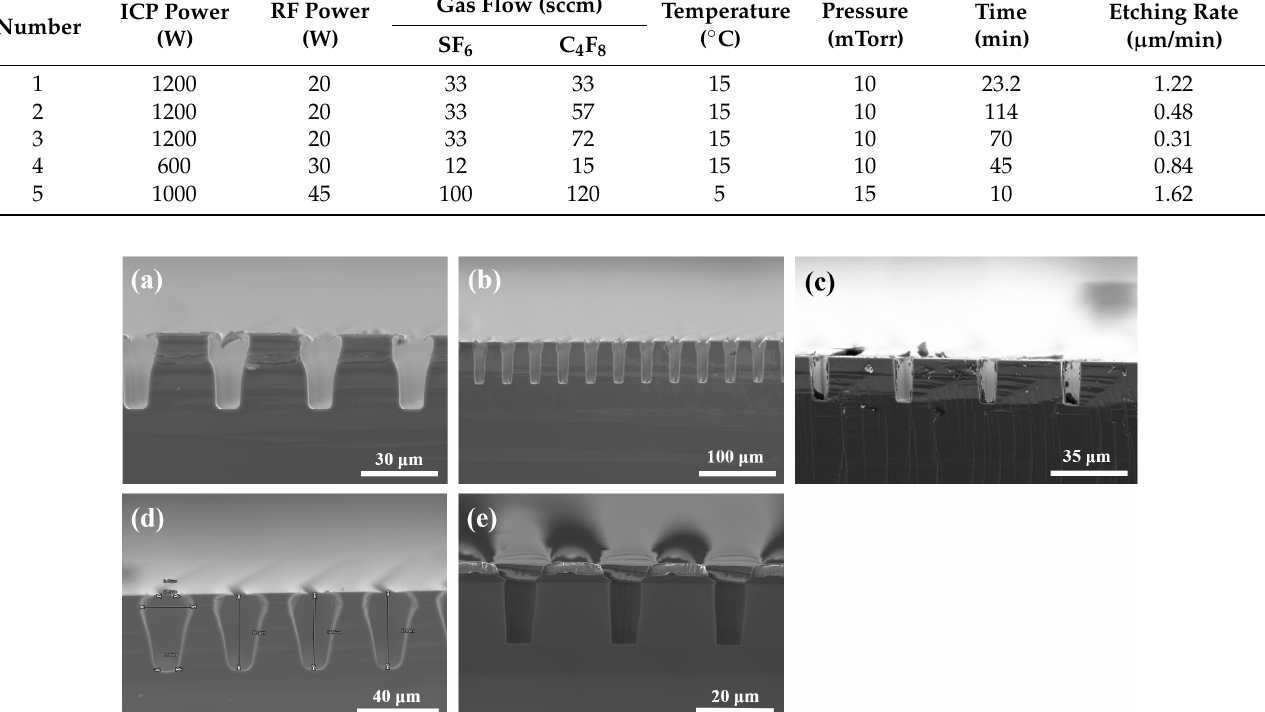
Figure 5. Different profiles of pseudo-Bosch experiments in ( a ) Group 1, ( b ) Group 2, ( c ) Group 3, ( d ) Group 4, and ( e ) Group 5.